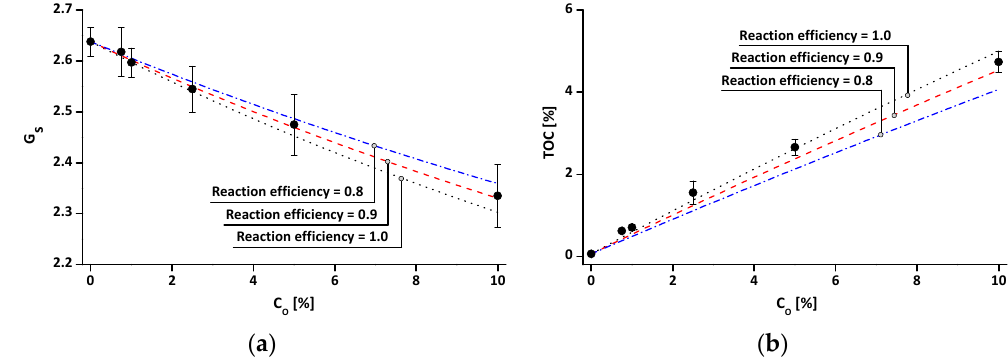
Figure 4. Effect of organosilane treatment concentration (C O ) on the index properties: ( a ) specific gravity (G s ); and ( b ) total organic carbon (TOC). Note that the error bars in the figures indicate standard deviations of measured values.